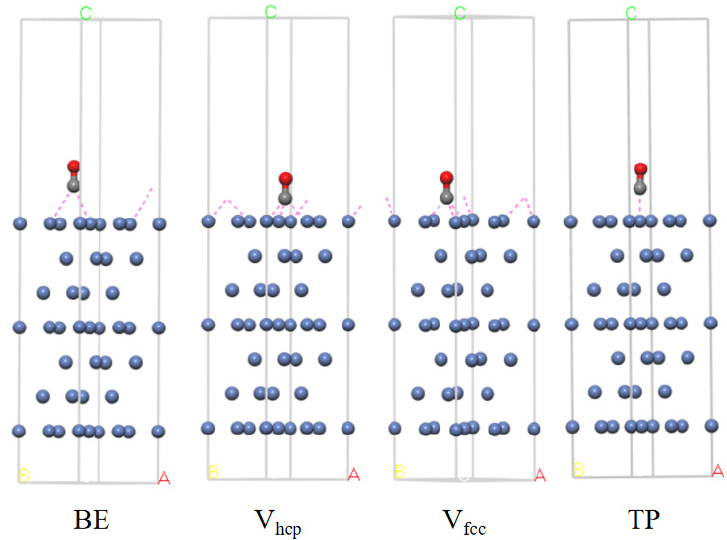
Figure 2. Four adsorption models of a CO and Ni (111) crystal surface.